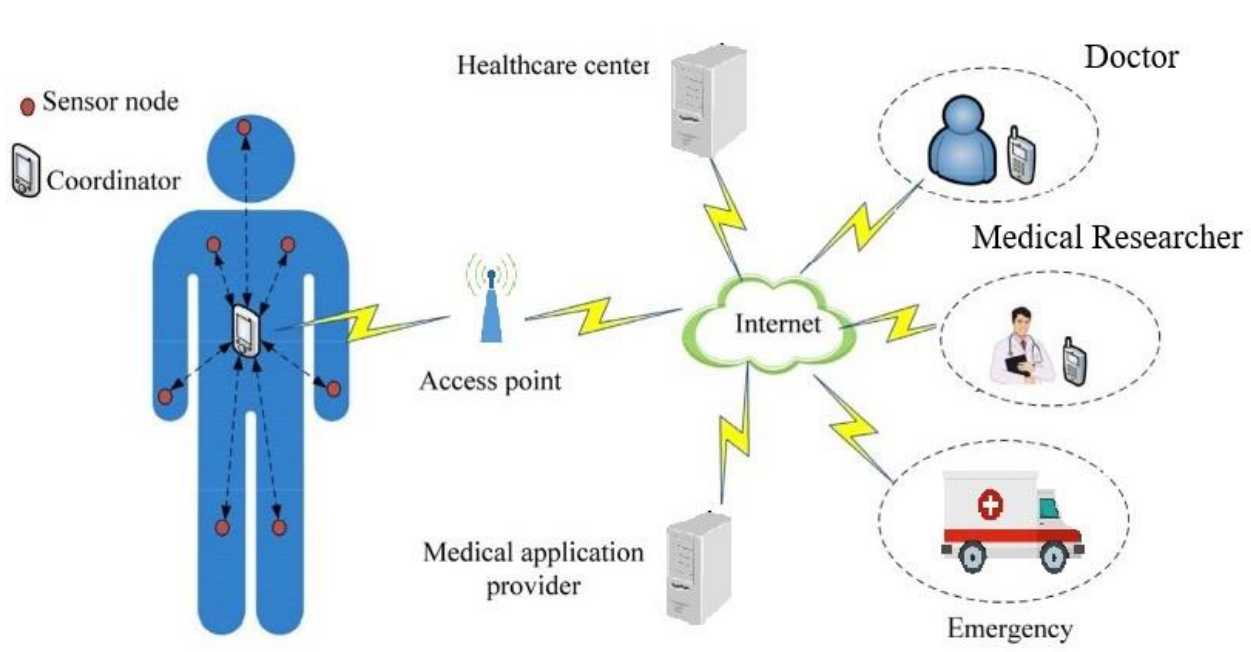
Figure 1 . the typical scenario of WBANs